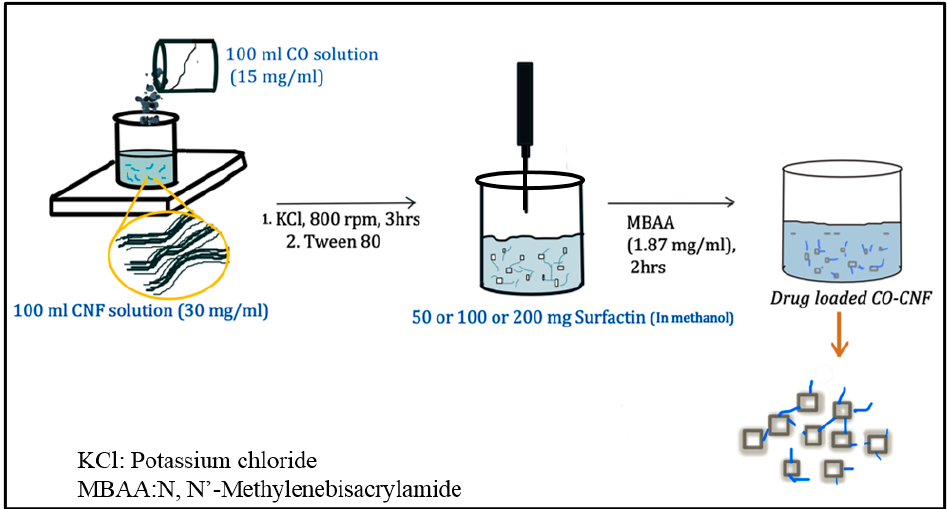
Figure 1. Schematic representation of surfactin-loaded nanoparticles preparation.